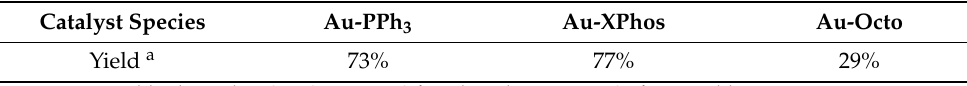
Table 1. Maximum catalytic yield of free catalysts in organic solvent. Catalyst Species